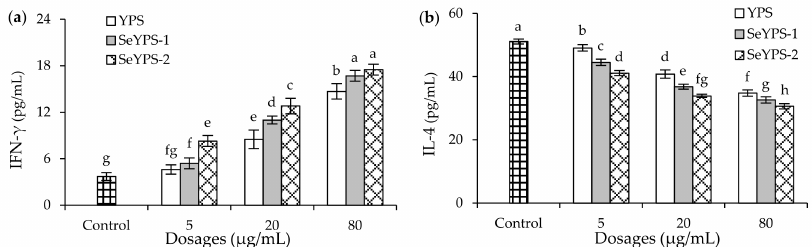
Figure 4. The production of IFN- γ ( a ) and IL-4 ( b ) in the splenocytes treated by YPS, SeYPS-1, and SeYPS-2 for 48 h. Different letters above the columns indicate that the one-way ANOVA of the mean values differs significantly ( p <